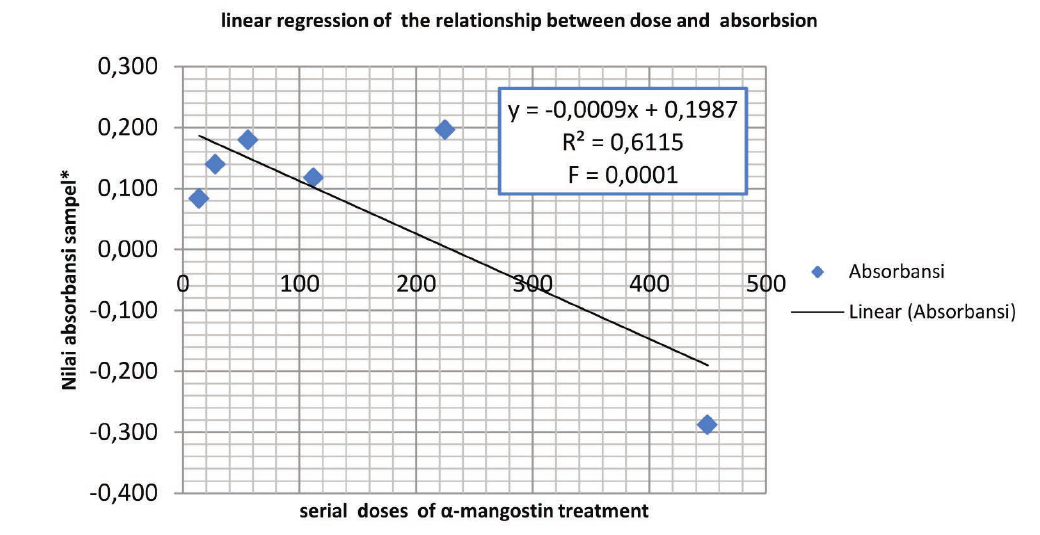
Figure 2. linear regression relationship between the dose of α -mangostin and absorbance values * * The absorbance is determined by evaluating the absorbance value of the treatment after incubation minus the absorbance value of the treatment prior to